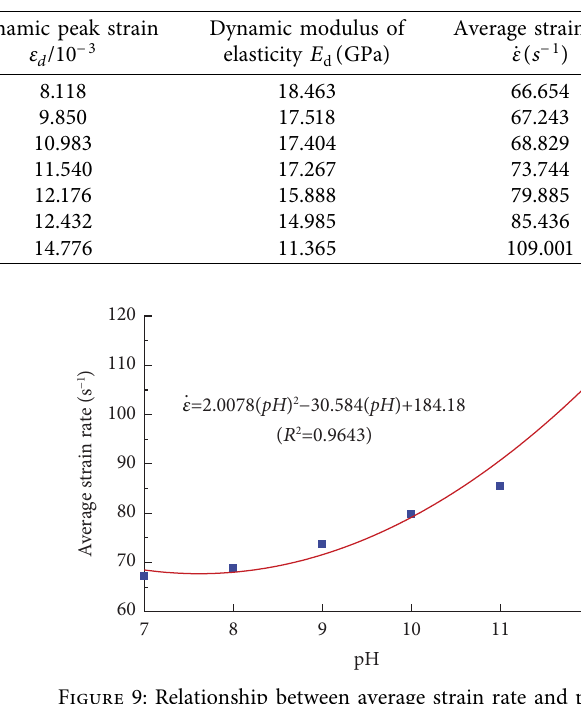
Figure 7: Relationship between dynamic peak strain and pH. Table 1: Selected dynamic mechanical parameters of some corrosion specimens.